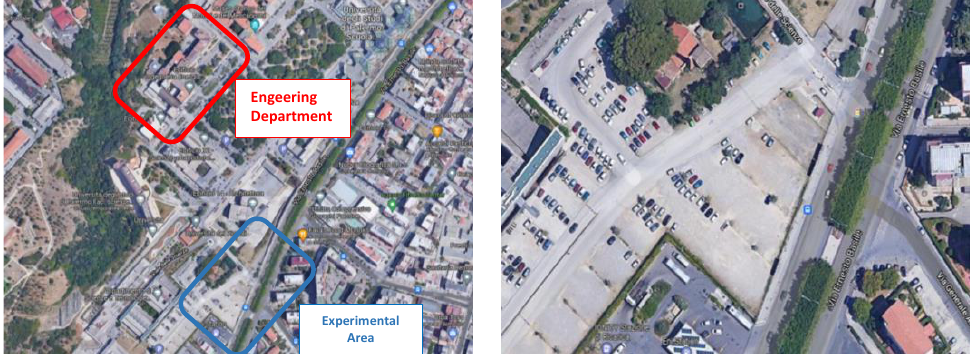
Figure 6. Experimental area in the UNIPA Campus.